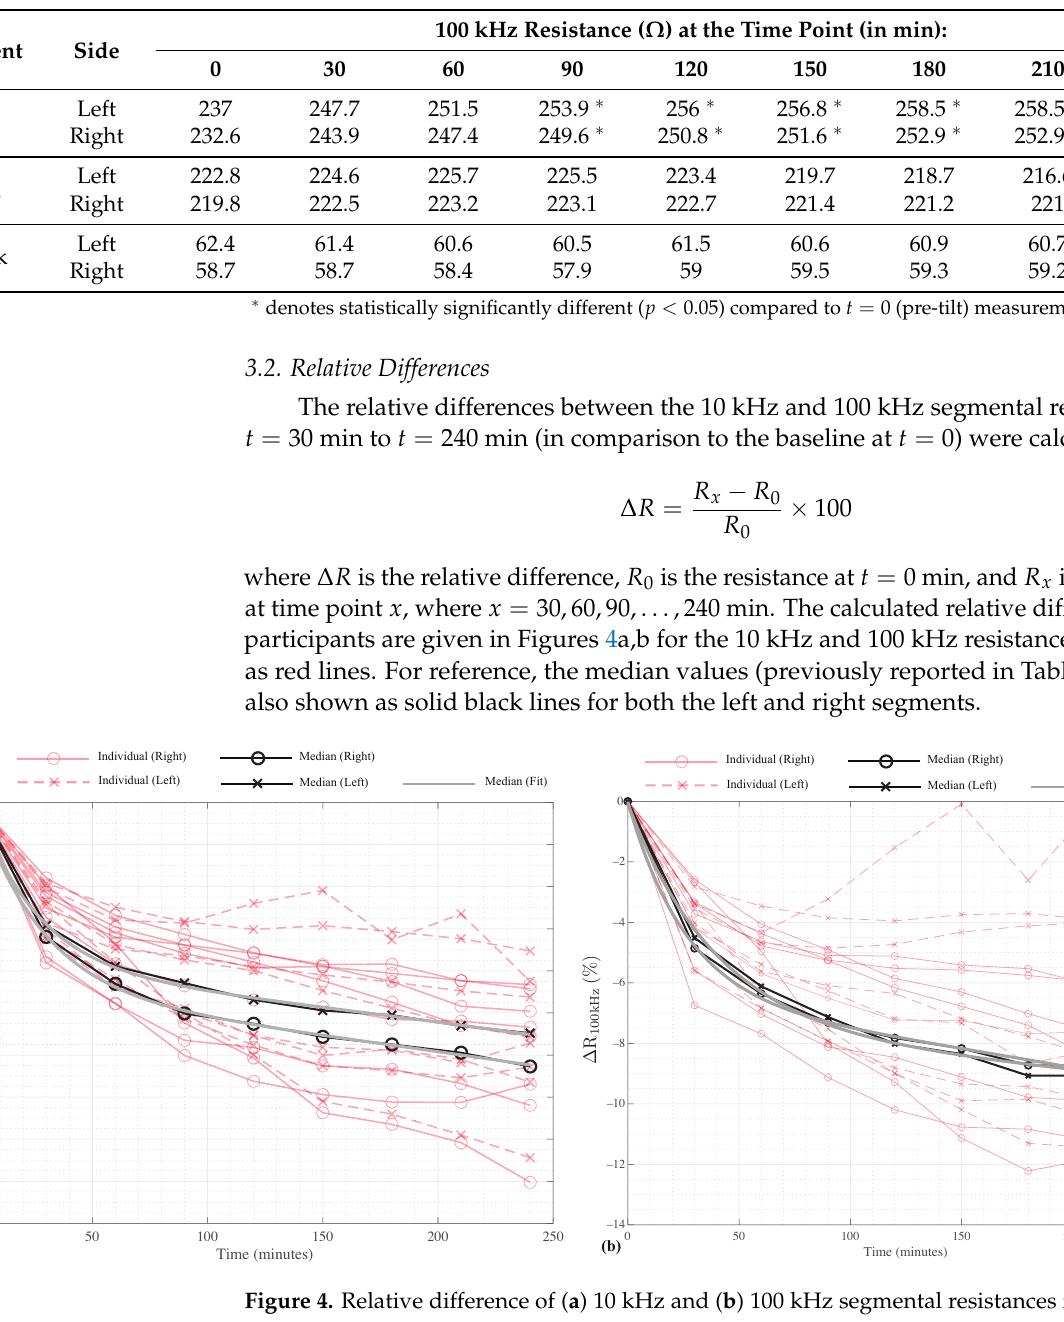
Table 3. Median 100 kHz resistance of left and right legs, arms, and trunk segments of the study participants.